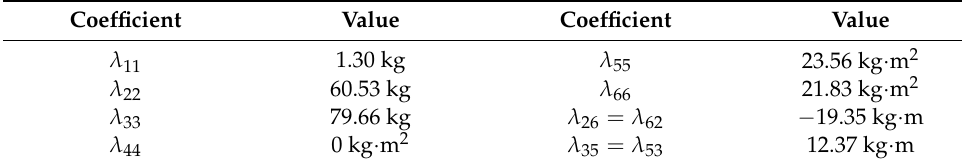
Table A2. Inertial hydrodynamic coefficients.